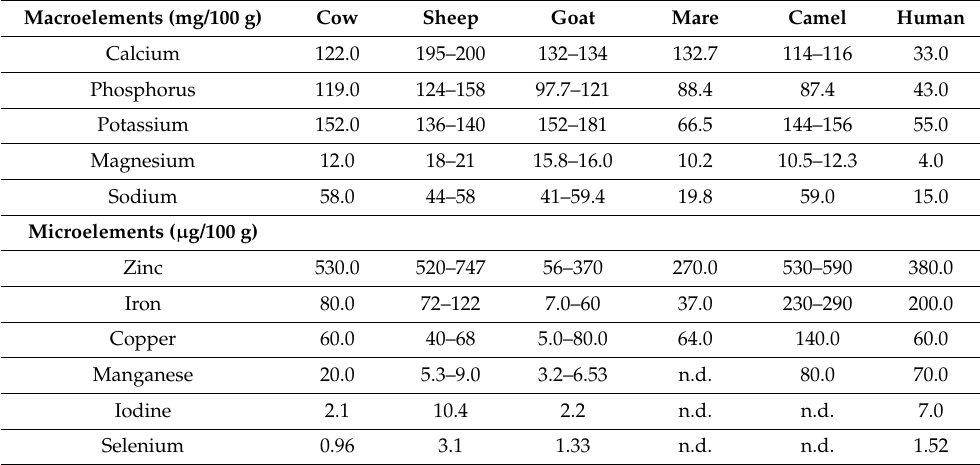
Table 5. Mineral concentrations in milk from different mammalian